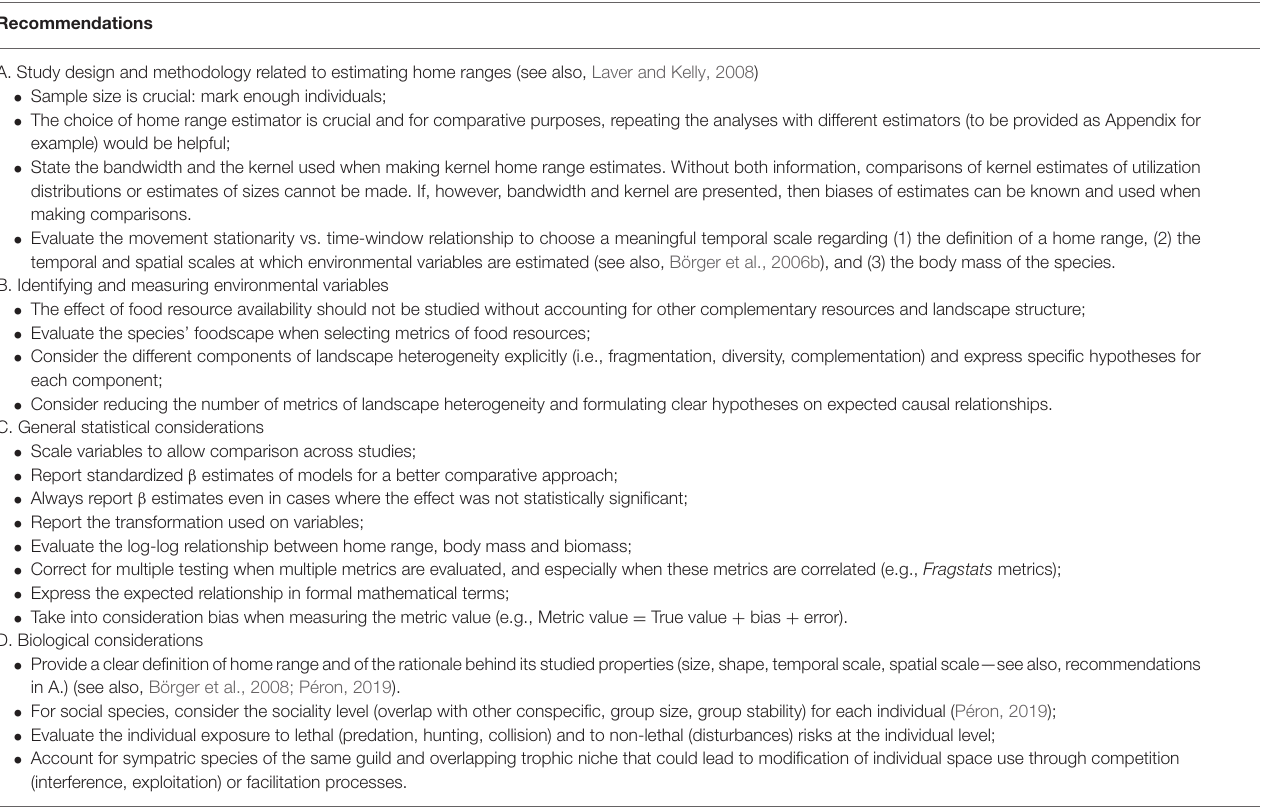
TABLE 4 | Recommendations for authors that should help quantitative studies aiming at evaluating the effect of the environment and life history traits on the size of home range.